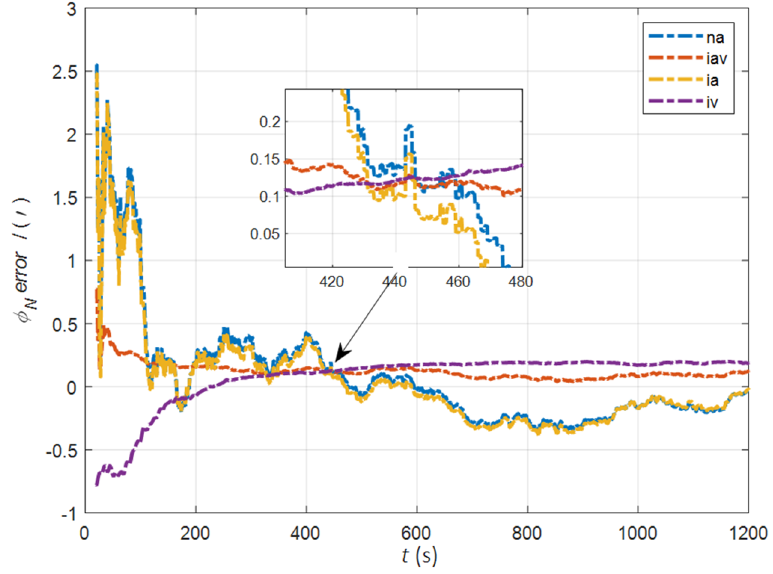
φ in the cases of the initial misalignment angles E